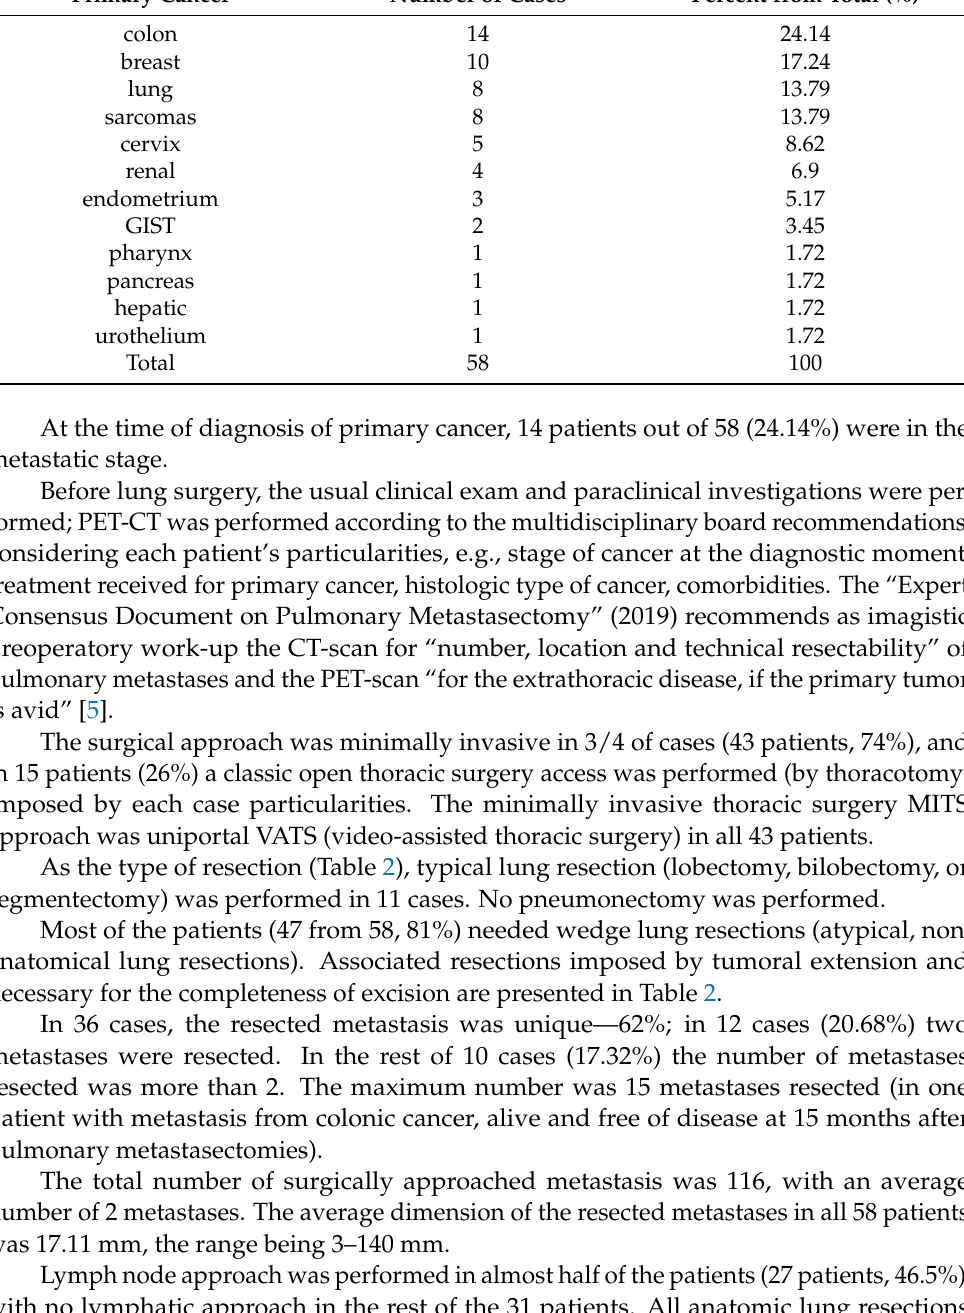
Table 1. The distribution of the patients with pulmonary metastases resected regarding their underly- ing malignancy. Primary